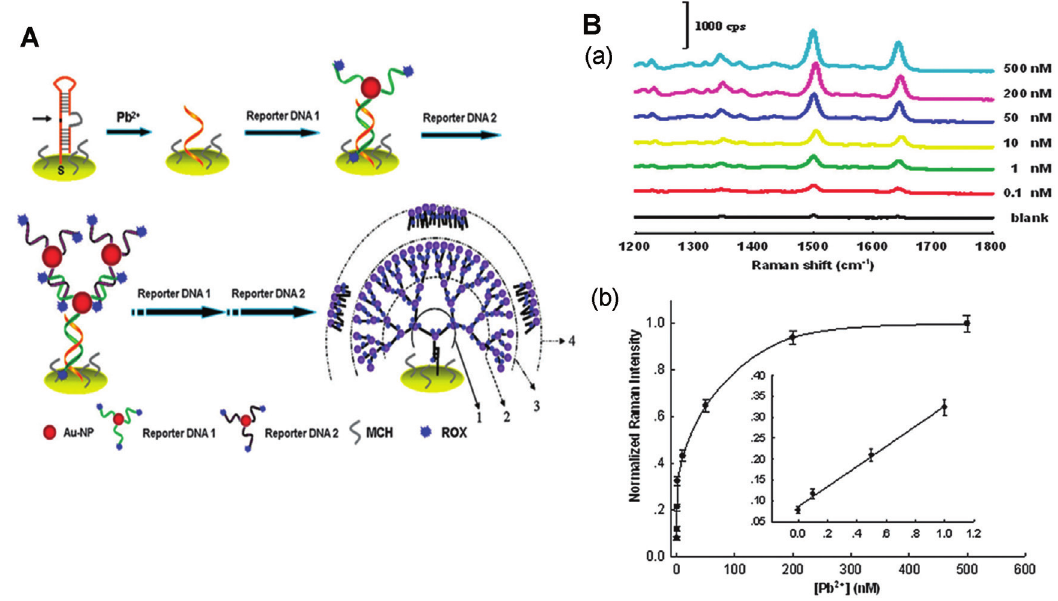
Figure 3 (A) Schematic of the amplified sensing strategy of the DNA-Au dendrimer-based SERS catalytic beacon for Pb 2+ . Rox stands for X-rhodamine, and MCH denotes 6-mercaptohexanol. (B) Sensitivity of the DNA-Au dendrimer-based SERS DNAzyme biosensor for Pb 2+ detection: (a) SERS spectra of the DNAzyme-based sensing interface with varying concentrations of Pb 2+ ; (b) Calibration curve of the SERS DNAzyme Pb 2+ sensor. Reprinted with with permission from: Sun et al. 2011. Copyright 2011, Royal Society of